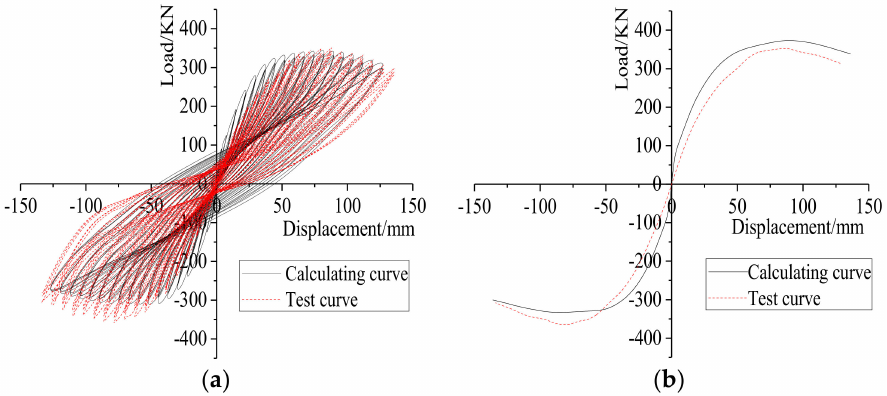
Figure 10. Comparison of hysteretic and skeleton curves: ( a ) Hysteretic curve and ( b ) Skeleton